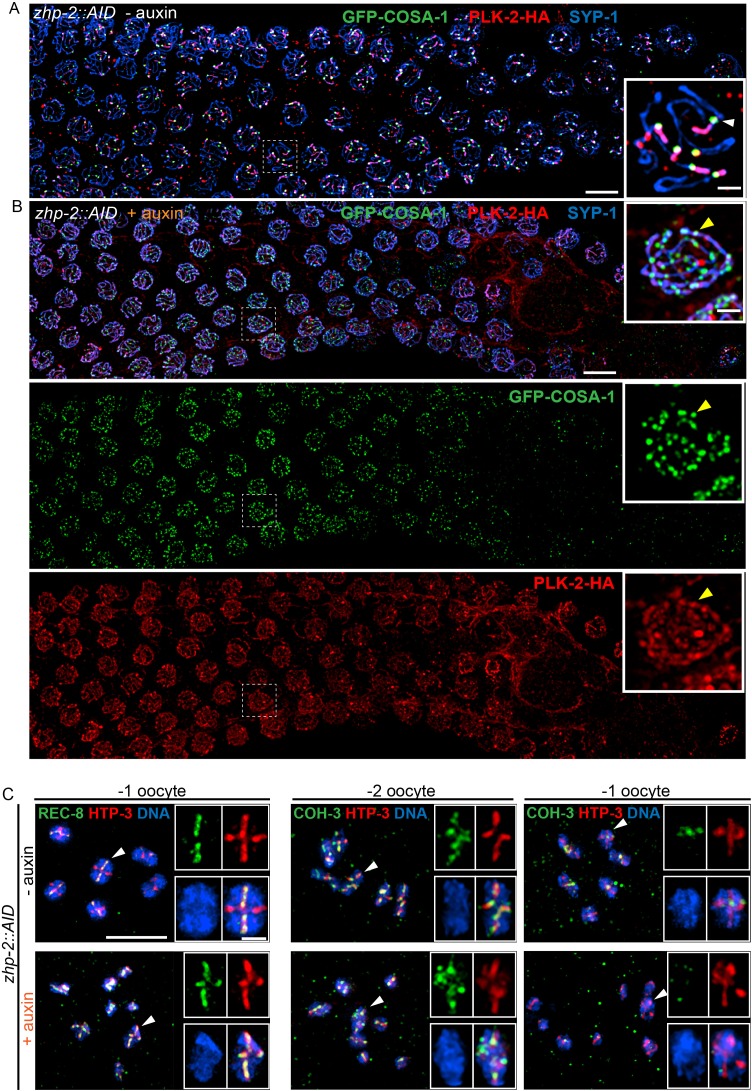
ZHP-1/2 are required for chromosome remodeling.(A,B) ZHP-2 is required for asymmetric localization of PLK-2 following crossover designation. (A) In wild-type nuclei, and in animals expressing ZHP-AID in the absence of auxin, PLK-2 (red) concentrates along the presumptive short arms during late meiotic prophase. (B) When ZHP-2 is depleted, PLK-2 localizes to a subset of recombination intermediates, but does not show asymmetric localization along the SCs. (C) High-magnification images of maturing oocytes stained for the kleisin proteins REC-8 or COH-3 and the HORMA domain protein HTP-3, which persists along all arms of bivalents. Worms were treated with or without auxin for 48 hr. In the most mature, or ‘–1’ (relative to the spermatheca) oocyte in each arm of the gonad, REC-8 normally becomes enriched on the long arms, while COH-3 is retained on short arms. In the absence of ZHP-2, removal of REC-8 from short arms was defective and retention of COH-3 was rarely observed. Scale bars, 5 µm. Scale bar for insets, 1 µm.